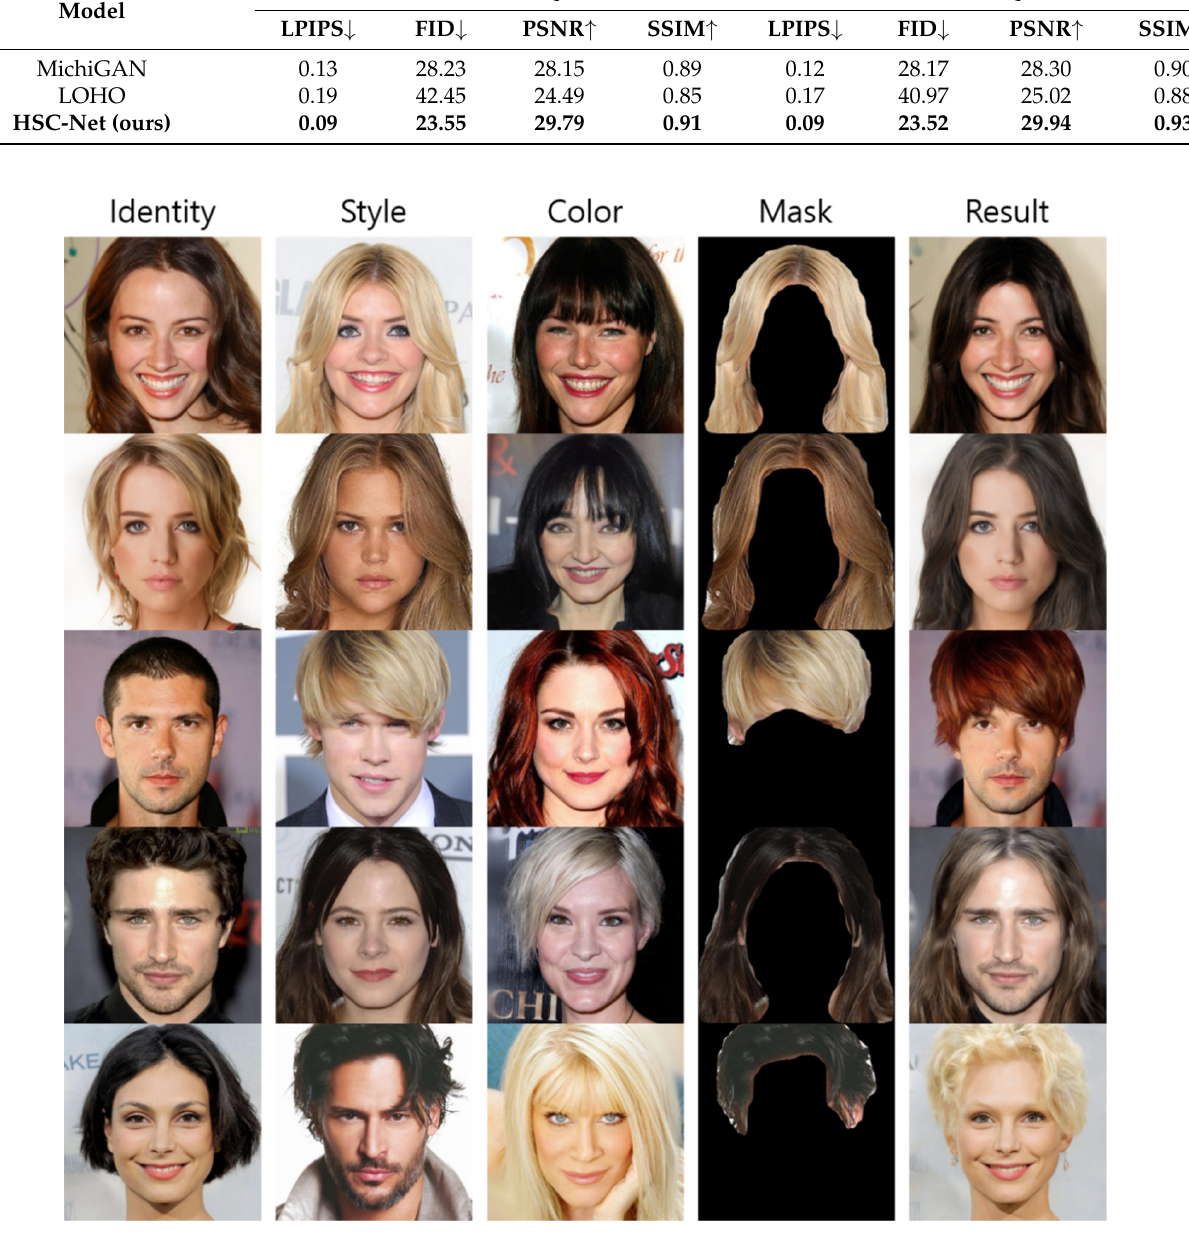
Figure 9. Resulting images of our model using different styles and colors for identity.